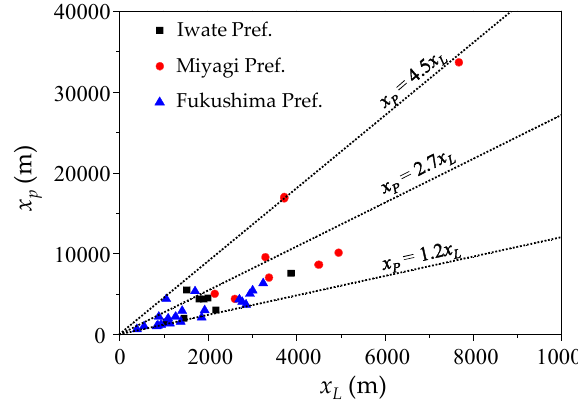
Figure 5. Relationship of tsunami intrusion distance inside of river and land area.